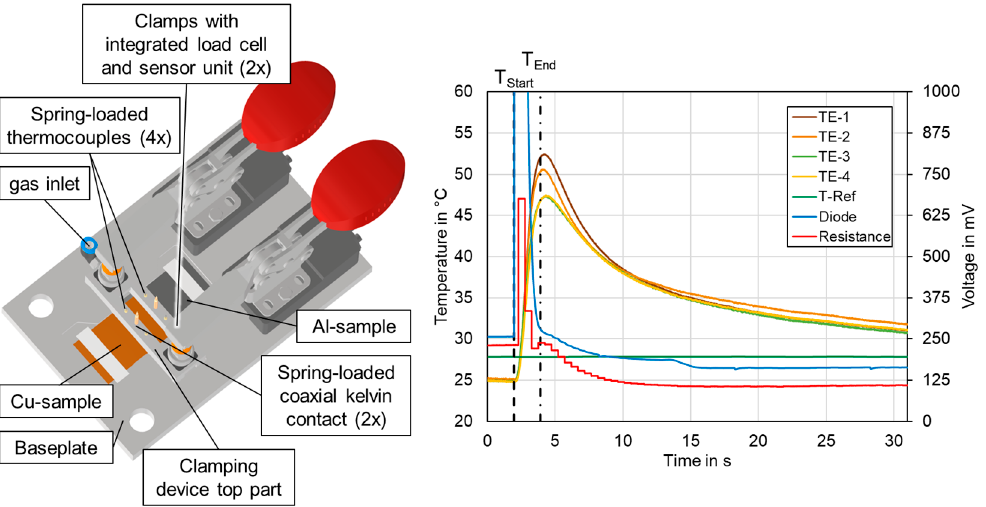
Figure 29. Sample fixture with integrated sensors for the in-line measurement of seam performance during welding.